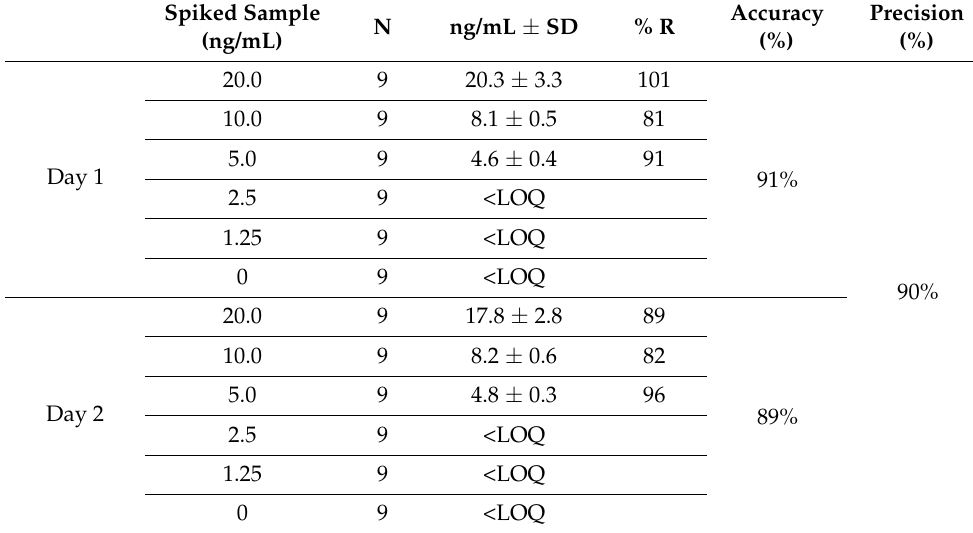
Table 1. Analysis of the spiked urine samples by sandwich ELISA. Results are expressed as ng/mL of 33-mer (mean ± SD) and percentage of recovery (R). N = number of analyses; <LOQ, less than the limit of quantification; SD, standard deviation. Spiked Sample N ng/mL ± SD % R (ng/mL)